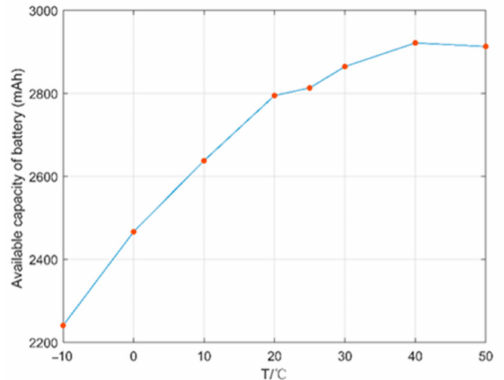
Figure 11. The capacity curve of ternary lithium-ion battery changing with temperature.